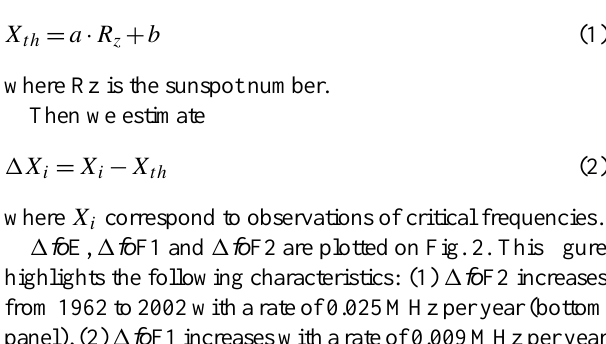
Cycles Minimum Increasing Maximum Decreasing phase phase phase